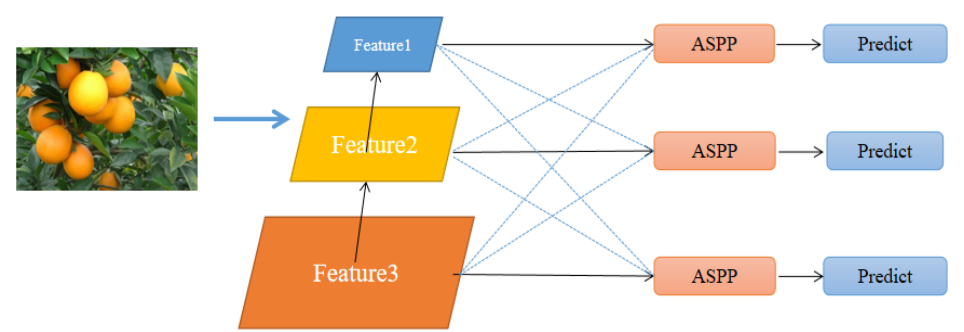
Figure 7. The feature map output from the model is fused adaptively.